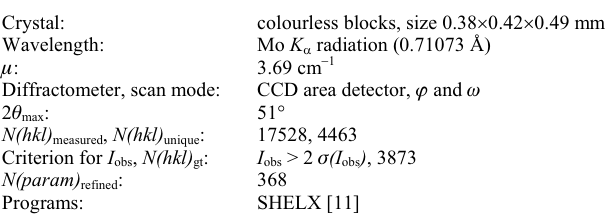
Table 1. Data collection and handling.